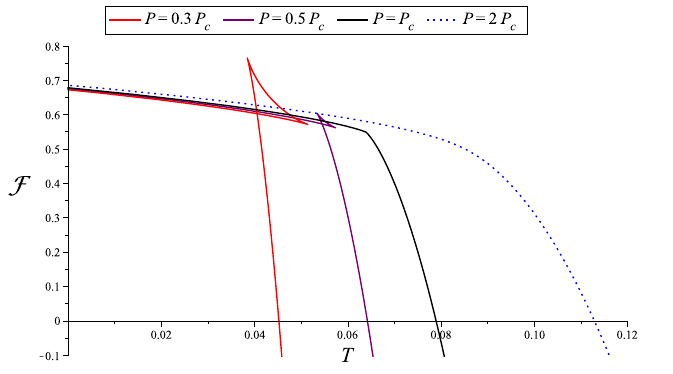
Figure 5 . Equation of state depicted for Q = 0 : 1 (at the left hand side) and Q = 0 : 3 (right hand side).